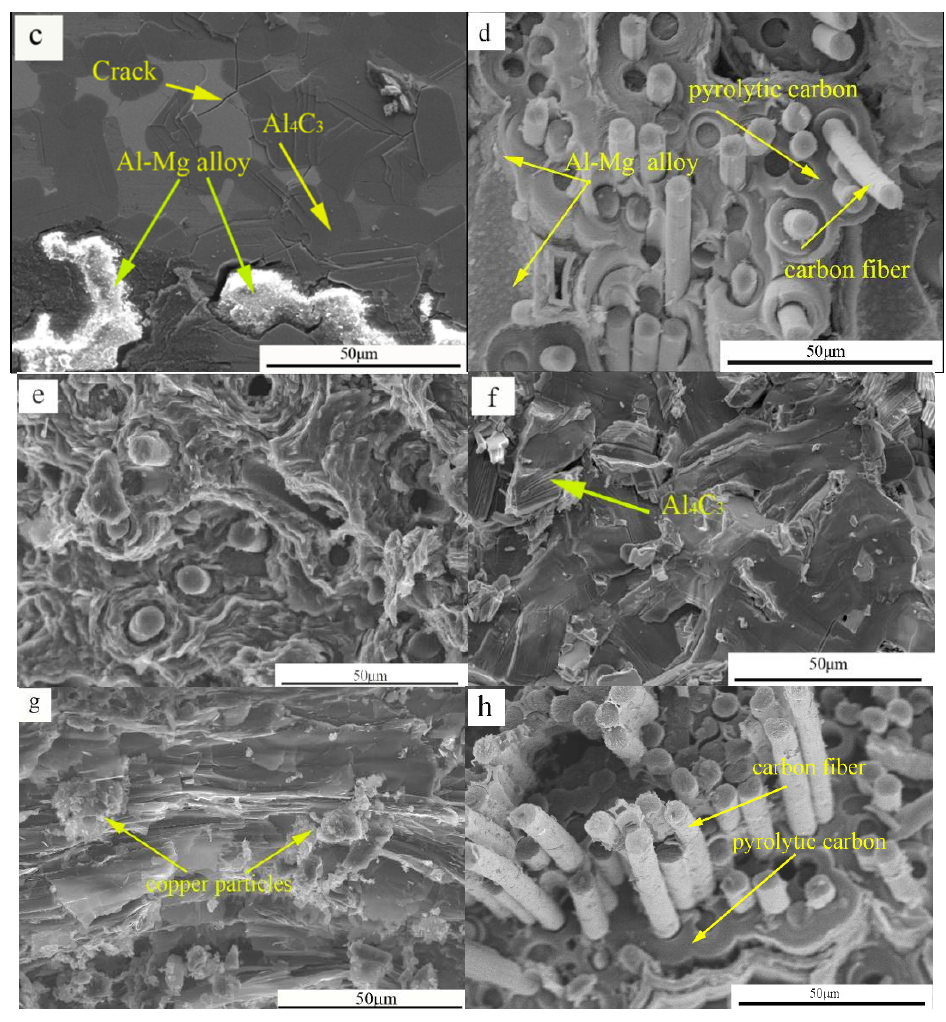
Figure 5. SEM micrographs and fracture micrographs of C/C–Al–Mg composites under different vacuum heat treatment temperatures. ( a , d ) 1000 °C, ( b , e ) 1200 °C, ( c , f ) 1400 °C, and ( g ) fracture micrographs of the steeped metal slider. ( h ) Fracture micrographs of the C/C composite.